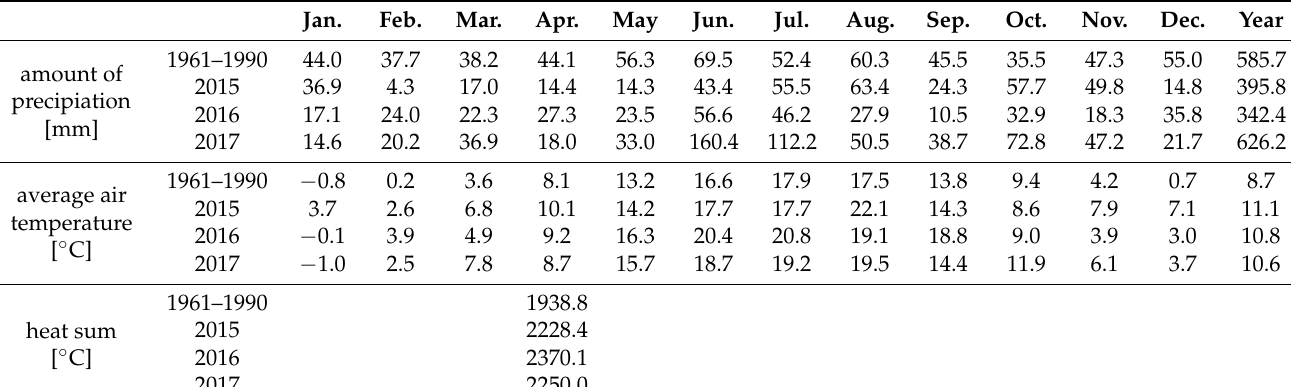
Table 3. Climate data for the trial years and the reference period 1961 to